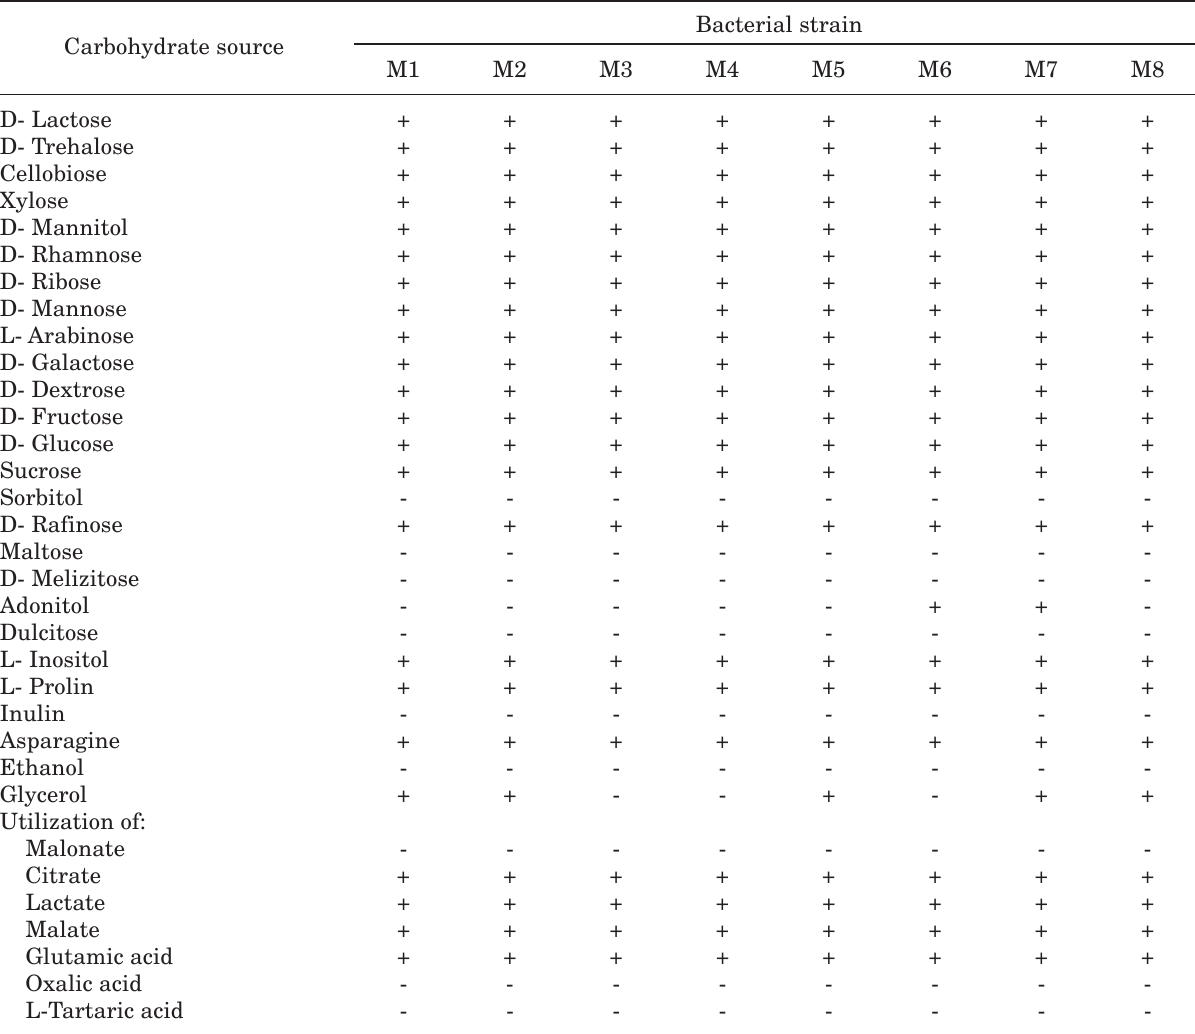
Table 3. Acid production from carbohydrates used for the identification of soft rot Pectobacterium isolated from